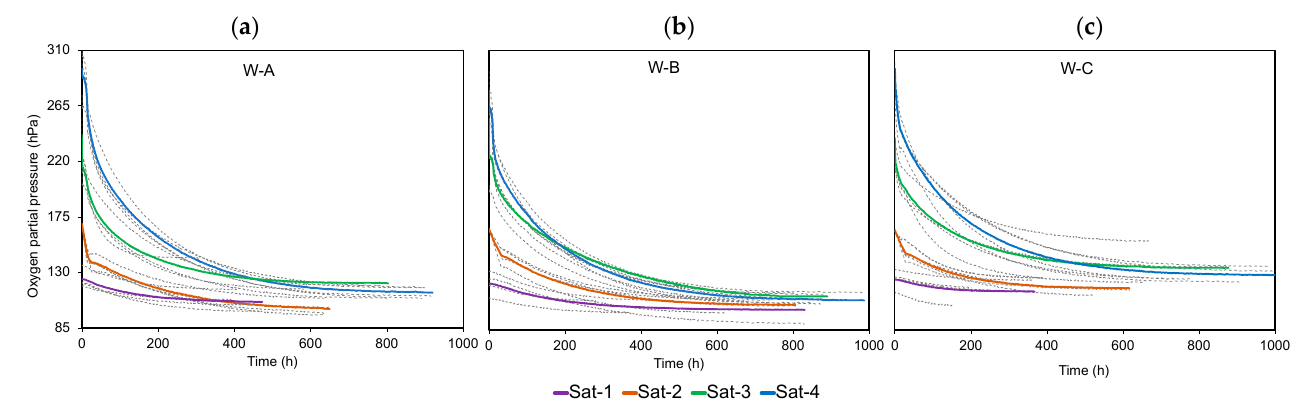
Figure 1 . Oxygen consumption kinetics ( a ) W-A ( n = 4), ( b ) W-B ( n = 4), and ( c ) W-C ( n = 4) for each saturation level (Sat-1: purple, Sat-2: orange, Sat-3: green, and Sat-4:blue).